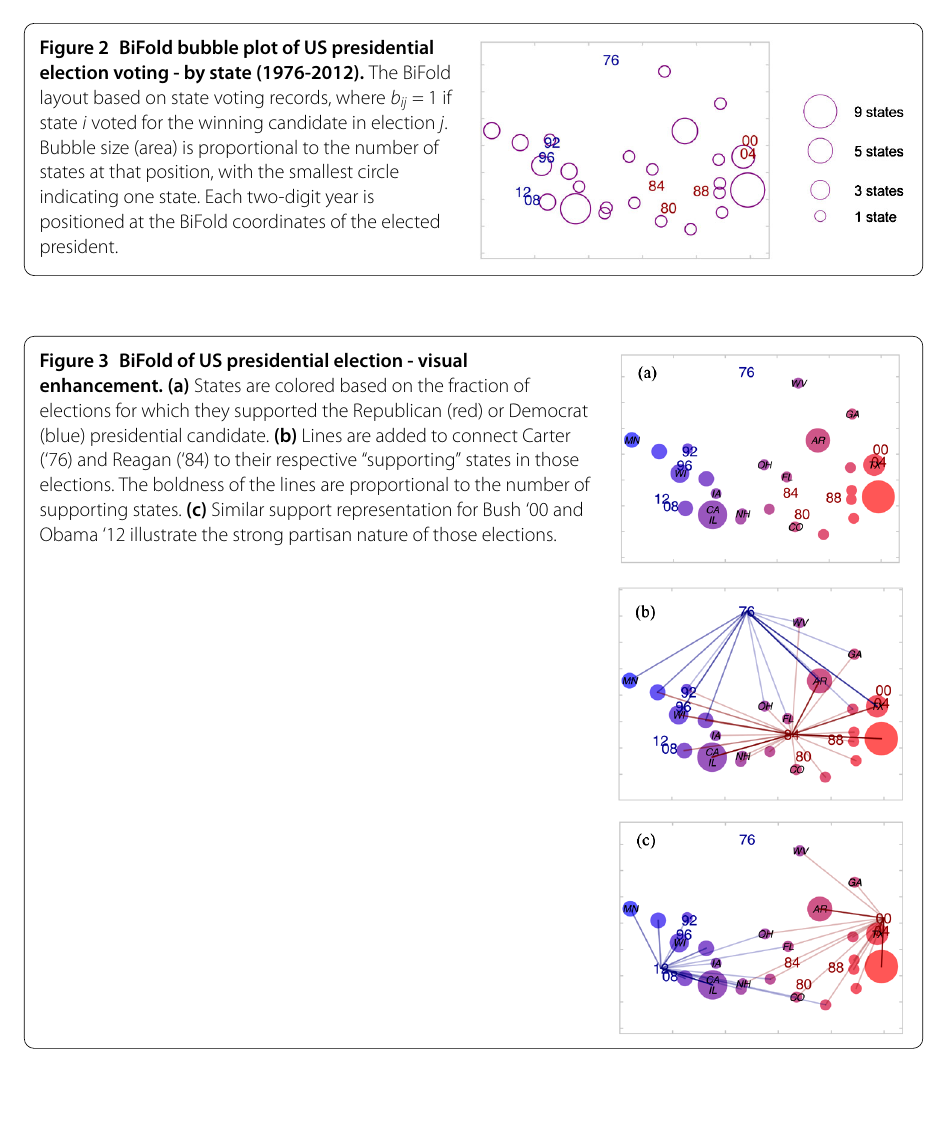
between state i and election j is quantified as  – b ij . Given these dissimilarities, Figure